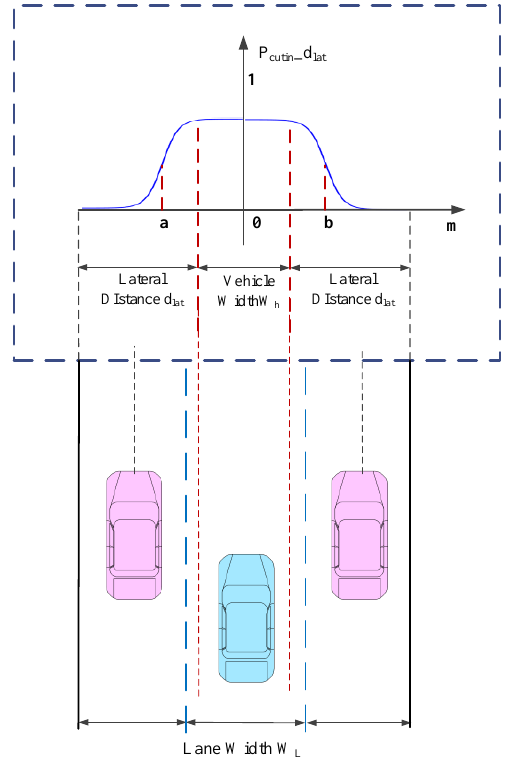
Figure 7. Cut-in possibility based on relative lateral distance.